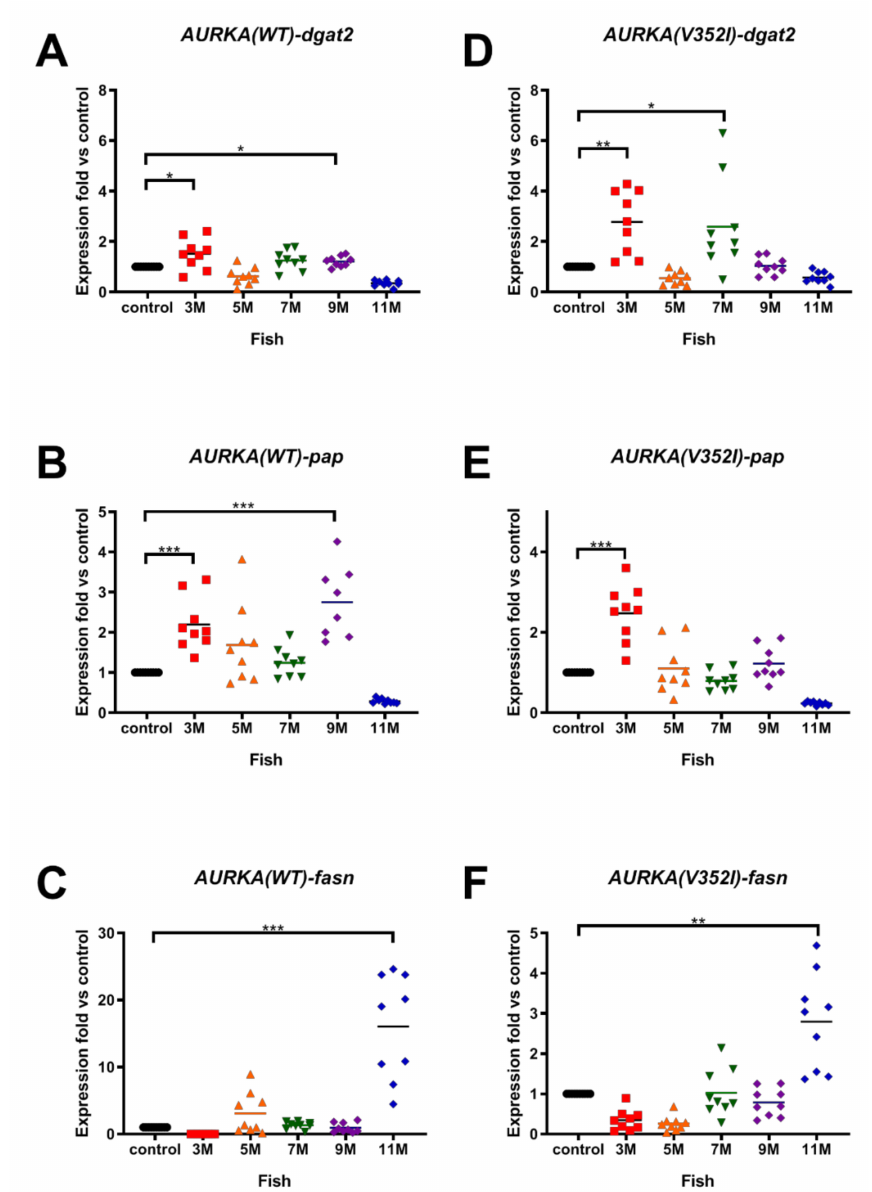
Figure 3. Expression of lipogenic enzymes (diacylglycerol O -Acyltransferase 2 ( dgat2 ), phosphatidate phosphatase ( pap ), fatty acid synthase ( fasn )) in AURKA(WT) and AURKA(V352I) transgenic fish were higher than control. qPCR analysis of lipogenic enzyme ( A , D ) dgat2 ; ( B , E ) pap ; ( C , F ) fasn in AURKA(WT) ( A – C ) and AURKA(V352I) ( D – F ) transgenic zebrafish compared to control fish at di ff erent time points. Expression fold compared to control fish (Tg(fabp10a:EGFP-mCherry) is shown in red (3 M), orange (5 M), green (7 M), purple (9 M), and blue (11 M). Statistical analysis of results was performed using a two-tailed Student’s t -test. Asterisks (*) represent the level of significance. * p -value ≤ 0.05; ** p -value ≤ 0.01; *** p -value ≤